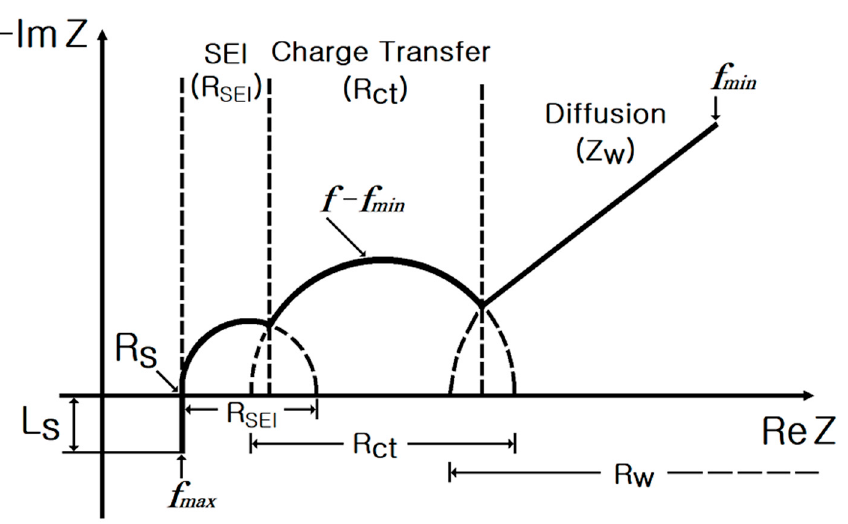
Figure 4. Complex plane diagram of the impedance spectrum of a cylindrical Li-ion battery [5,7]. In Figure 4, the small semicircle, which is expressed using the film resistance ( 𝑅 (cid:3020)(cid:3006)(cid:3010) ) and the capacitor ( 𝑄 (cid:3020)(cid:3006)(cid:3010) , 𝛼 (cid:3020)(cid:3006)(cid:3010) ), corresponds to the charge transfer of the solid electrolyte interface (SEI) generated by the inner electrode. The Warburg impedance ( 𝑍 (cid:3024) ), which is the diffusion region, denotes the diffusion of solid-state Li ions, and it increases with a slope of 45° in the complex plane [6,8]. 𝑍 (cid:3024) can be expressed as follows [8,9]: